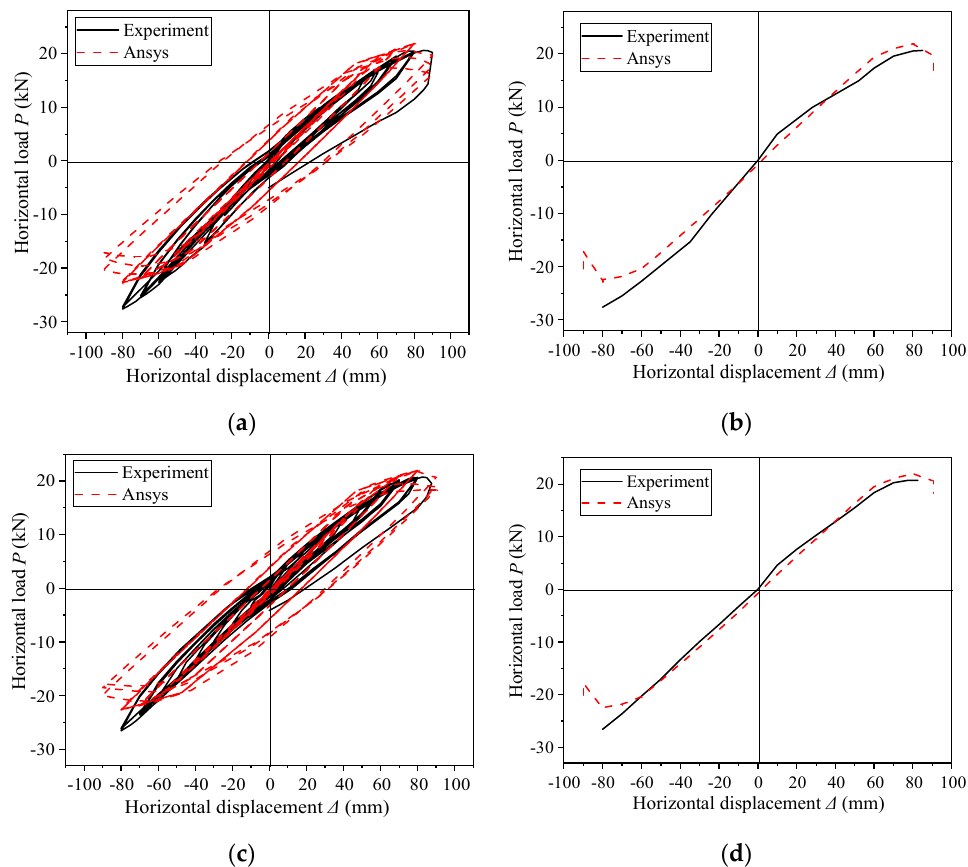
Figure 18. Comparison of numerical analysis results with test results. ( a ) P – Δ curve of specimen SV2; ( b ) Envelope curves of specimen SV2; ( c ) P – Δ curve of specimen SV3; ( d ) Envelope curves of specimen SV3.